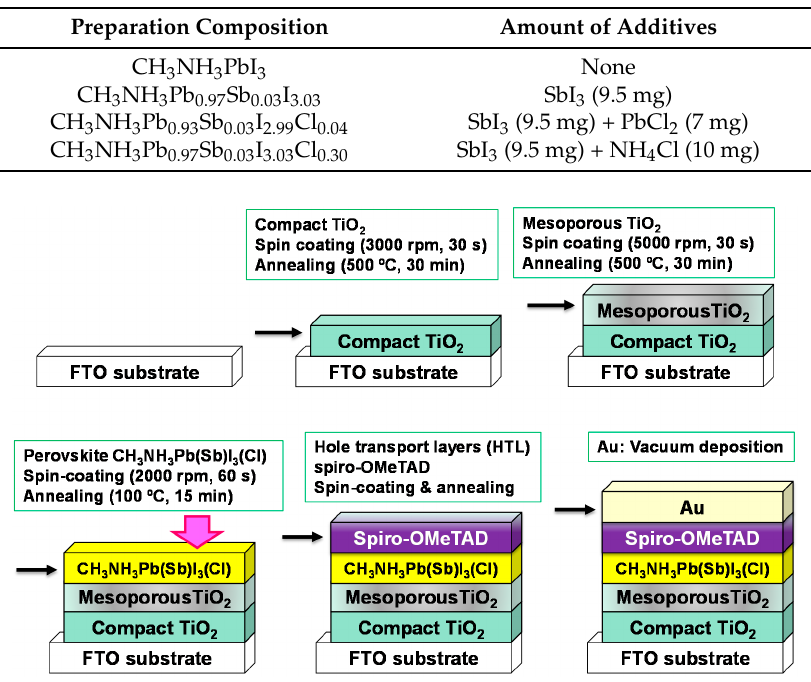
Table 1. Preparation composition of TiO 2 /CH 3 NH 3 Pb 1- x Sb x I 3 Cl 3- y cells with different additives.